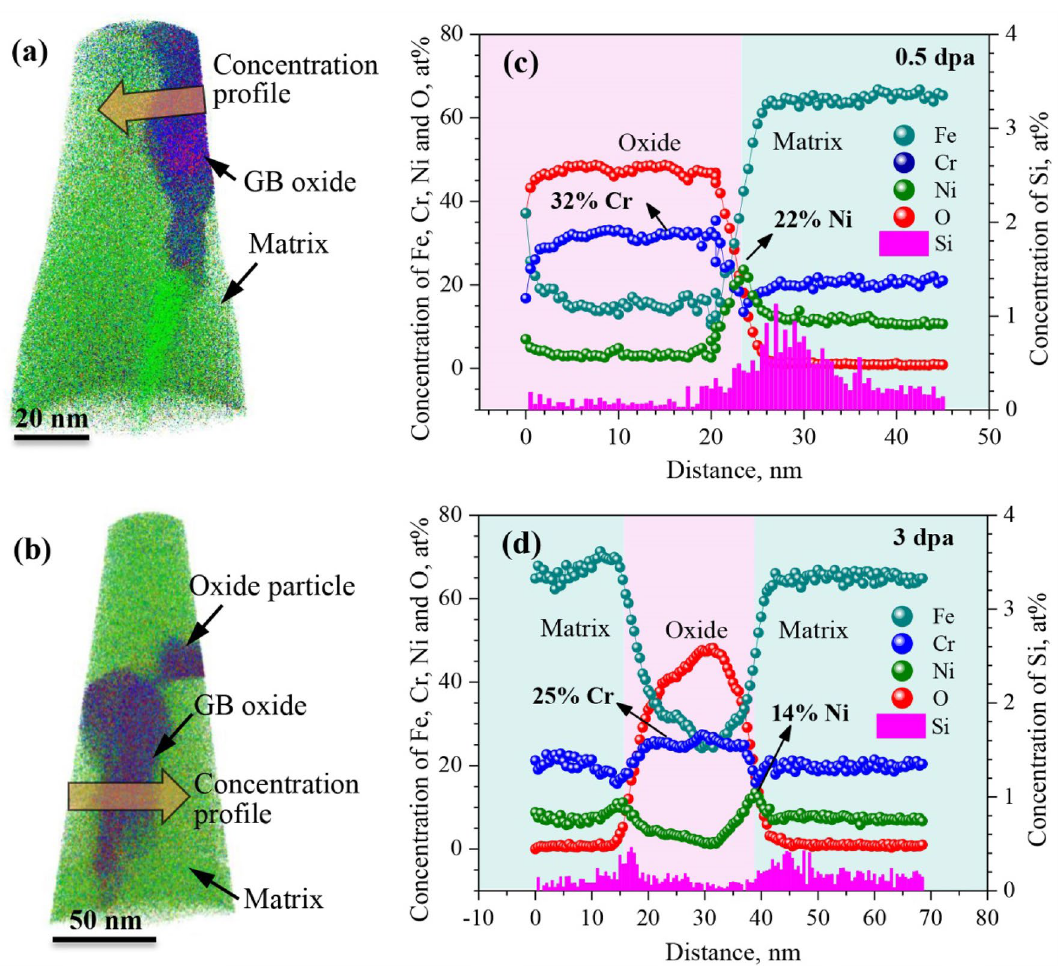
Figure 3. ( a ) and ( b ) Atom density maps of the 0.5- and 3-dpa irradiated specimens following the 500-h exposure in primary water at 320 °C, showing oxidation along the grain boundaries. ( c ) and ( d ) Corresponding 1D concentration profiles across the oxide/matrix interfaces, showing the oxide to be Cr-rich with asymmetric Ni and Si enrichment at the oxide/matrix interfaces. *Atom maps in Fig. 2a,b were reconstructed using the commercial CAMECA Imago Visualization and Analysis Software package (IVAS, Version 3.6.8). URL link: https:// www. cameca.